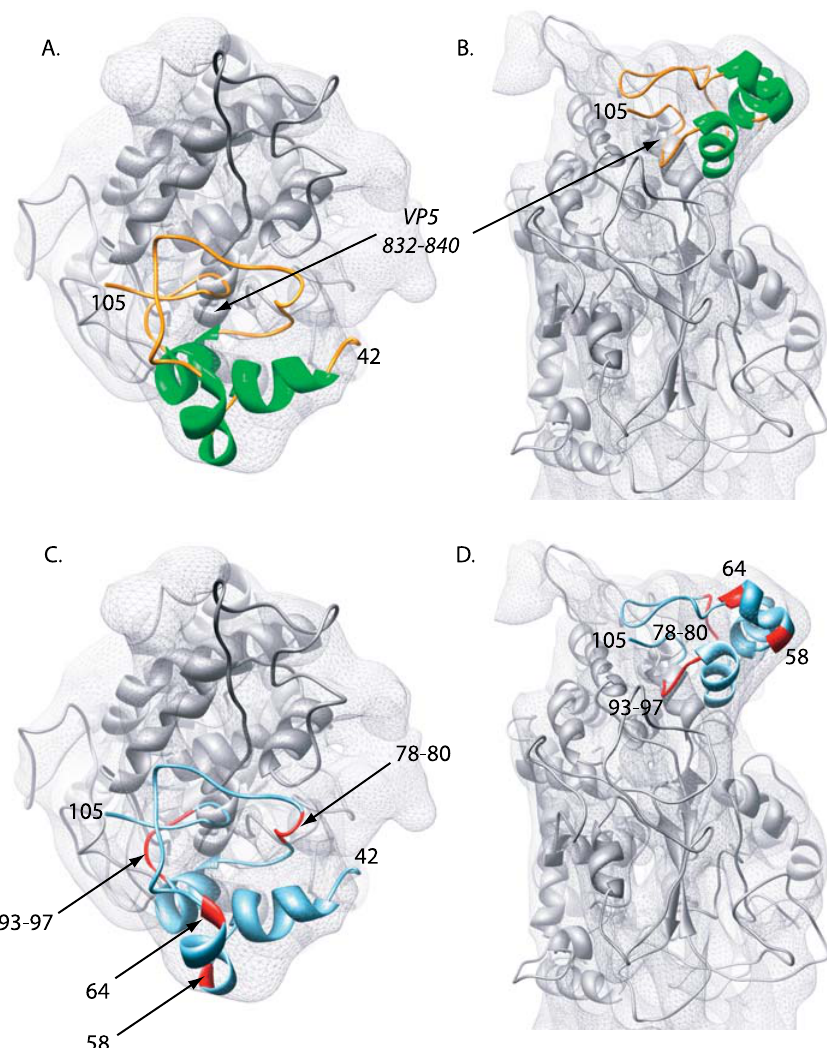
Figure 5. VP26 Interactions (A,B) The VP26 core domain model is shown in the context of the VP5 upper-domain X-ray structure (grey) in a top view and a side view, respectively. The a -helix in VP5 (832–840) that interacts with VP26 is labeled. (C,D) Mutations (labeled with arrows and highlighted in red on the ribbon diagram) in VP26 (cyan blue) that affect binding to VP5 as described by Desai et al. [32] are shown in top and side views, respectively. DOI: